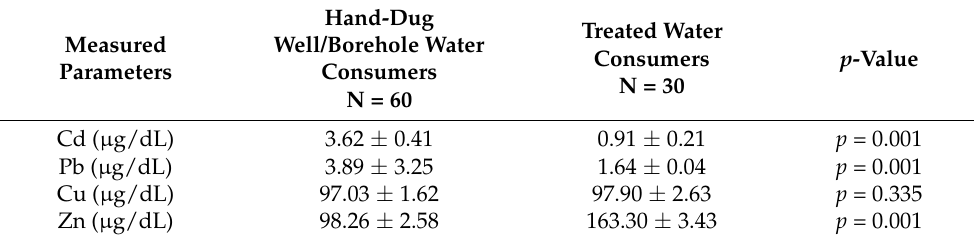
Table 3. Levels of Blood Cd, Pb, Cu and Zn among Hand-Dug Well/Borehole Water Consumers and treated water consumers.